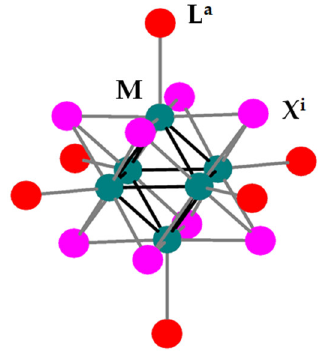
Figure 1. General representation of a [M 6 X i 8 L a 6 ] (M = Mo, W; X i = Cl, Br, I; L a = apical ligand) cluster unit.